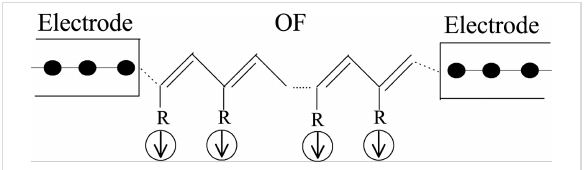
Figure 1: Schematic of an organic ferromagnetic device.